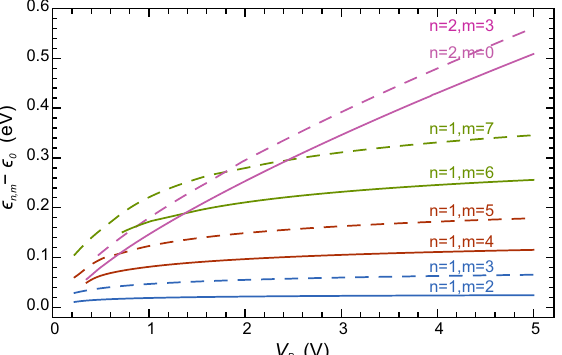
Figure 7. Excitation energies of several low-order eigenstates of model 1 vs. bias voltage. Full lines: Eigenfunctions symmetric with respect to Ox and Oy . Dashed lines: eigenfunctions symmetric to Ox and antisymmetric with respect to Oy . The eigenenergies of the n = 2 states depend more strongly on the bias voltage than those with n = 1. See text for the meaning of the quantum numbers n and m .